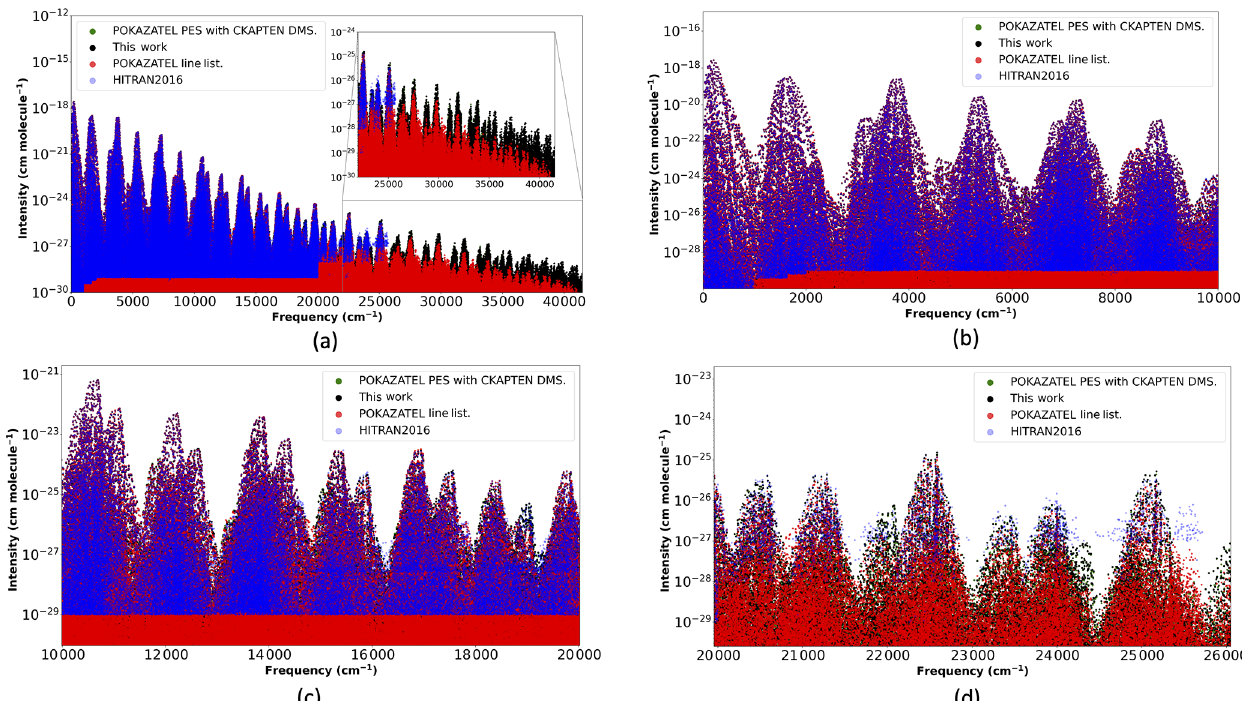
Figure 3. Transition intensities from the POKAZATEL line list (Polyansky et al., 2018), this work representing our new PES with the CKAPTEN DMS (Conway et al., 2018), the POKAZATEL PES combined with the CKAPTEN DMS and HITRAN2016 (Gordon et al.,